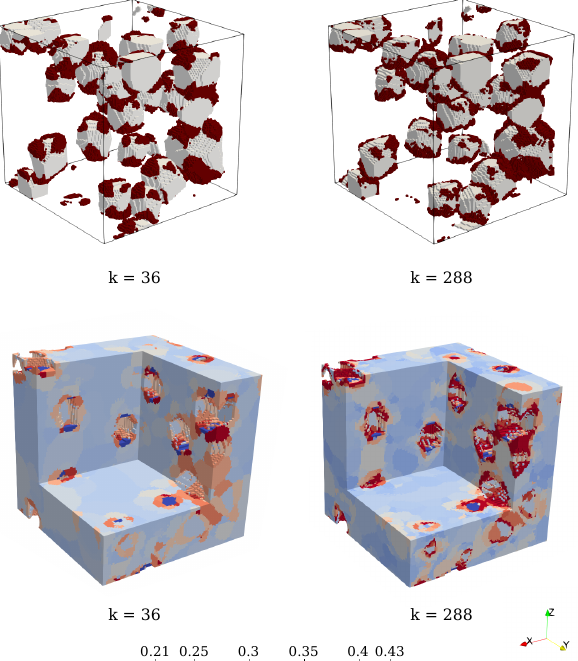
Figure 10. Top left and right: microcracking regions, whose average stiffness is less than 20% of the initial stiffness, obtained from ROS simulations with k ROS visualisation of mortar damage in terms of the distribution of the relative secant stiffness ( ¯ E rel , strain = 1.65 × 10 − 3 obtained from simulations with k ROS